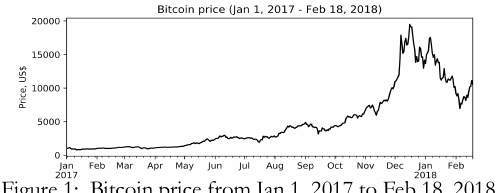
Figure 1: Bitcoin price from Jan 1, 2017 to Feb 18, 2018 Nakamoto. Bitcoin utilizes a technology